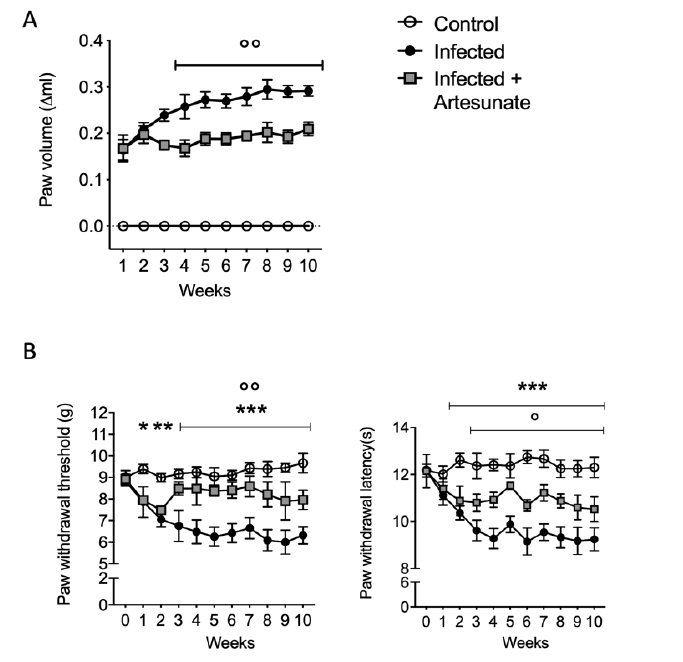
Figure 1. ( A ) Time course of paw volume after L. amazonensis infection; ( B ) time course of mechanical allodynia as paw withdrawal threshold (g) and thermal hyperalgesia as paw withdrawal latency. Data are expressed as mean ± SEM from N = 10 mice for each group. *** p < 0.001 vs. control group; ** p < 0.01 vs. control group; * p < 0.05 vs. control group; °° p < 0.01 vs. infected group; ° p < 0.05 vs. infected group.